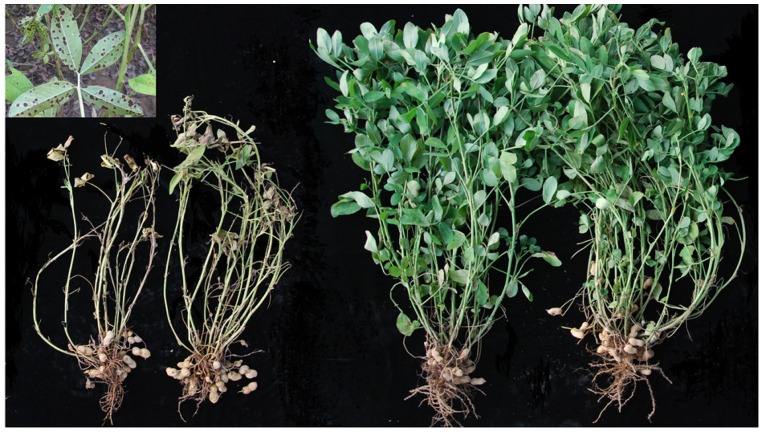
Phenotypes of two parental inbred lines used for QTL mapping in this study.Plants were photographed at 120 days after sown on soil. Left two lines were Zhonghua 5, right two lines were ICGV 86699. The picture of top left corner showed infected leaves by late leaf spot.